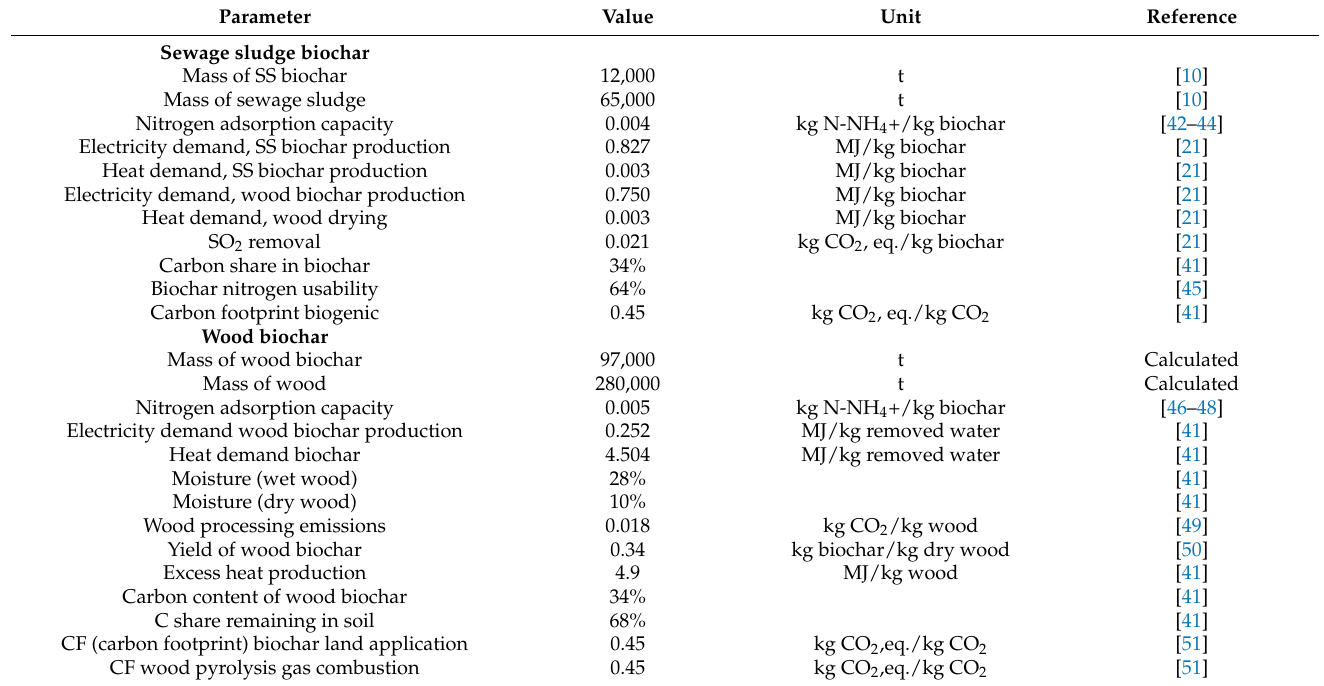
Table 6. Parameters of the adsorption